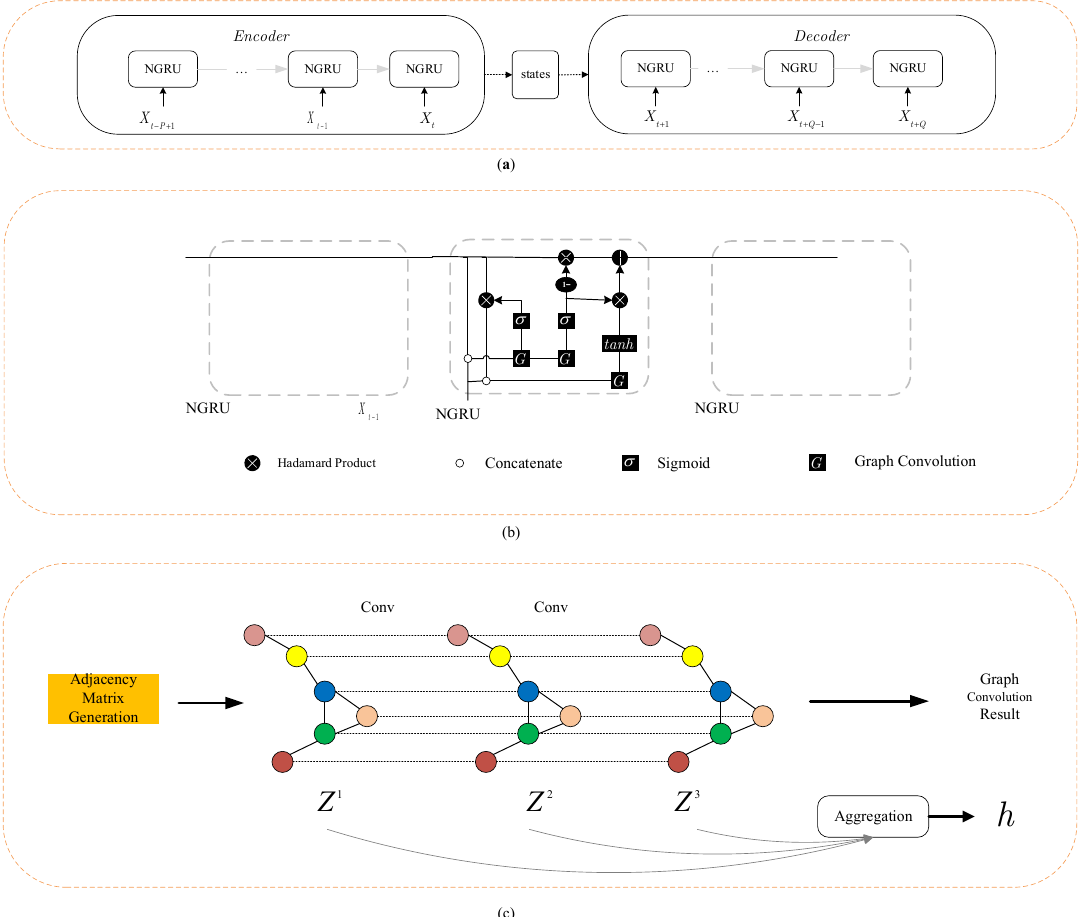
Figure 4. The composition of the NGC module, (a) the structure of the encoder–decoder model, (b) the structure of NGRU, (c) the structure of adaptive graph convolution.